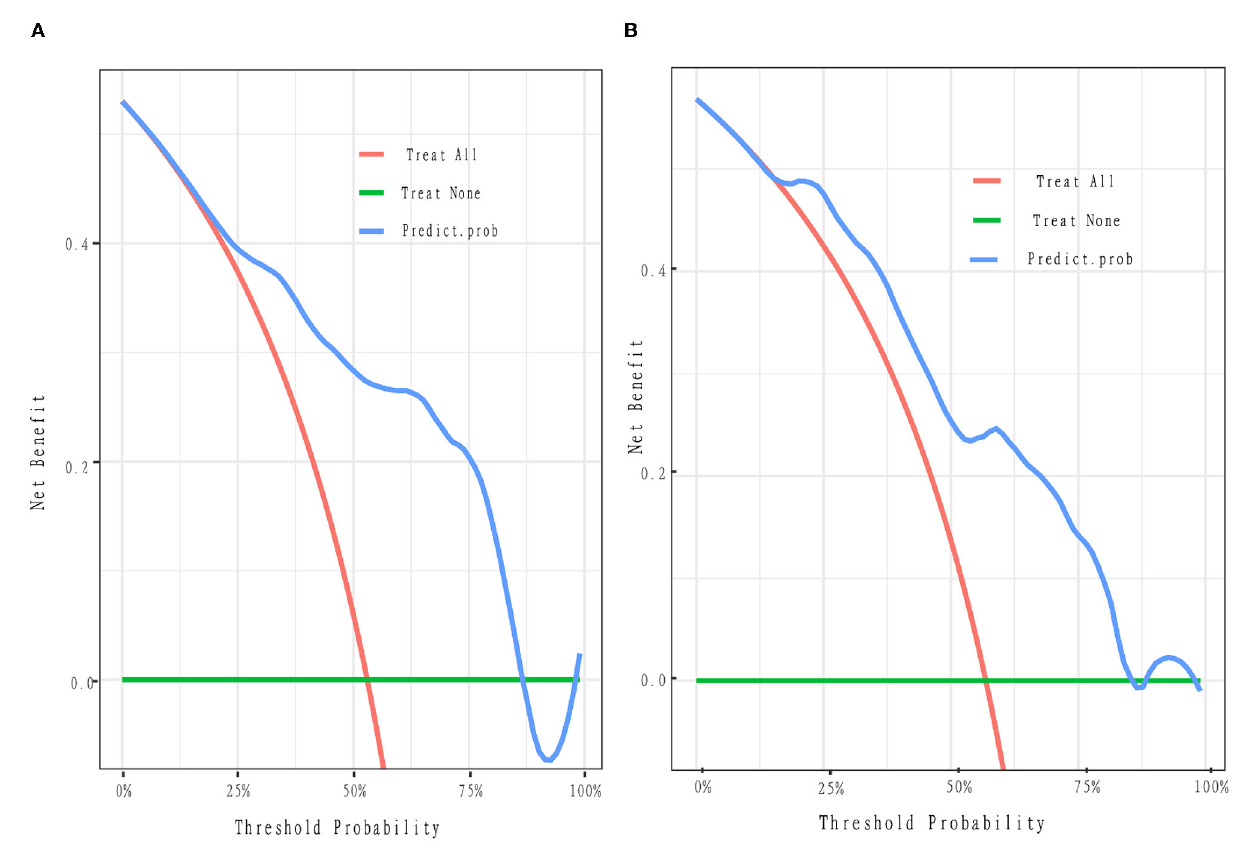
FIGURE4 Decision curve. The y-axis represents the net benefit. The x-axis is the threshold probability. The blue curve represents the nomogram. The red oblique represents the hypothesis that all patients with pDOC have improved outcomes with all treatments. The green line represents the hypothesis that no patients will have improved outcomes. The threshold probability is where the expected benefit of the treatment is equal to the expected benefit of no treatment. For example, if the possibility of the improved outcome of a patient is over the threshold probability, then the patients with pDOC will not benefit from all the treatment strategy. (A, B) Depict the decision curves of the training and validation cohorts, respectively. Net benefit means the clinical efficacy of the